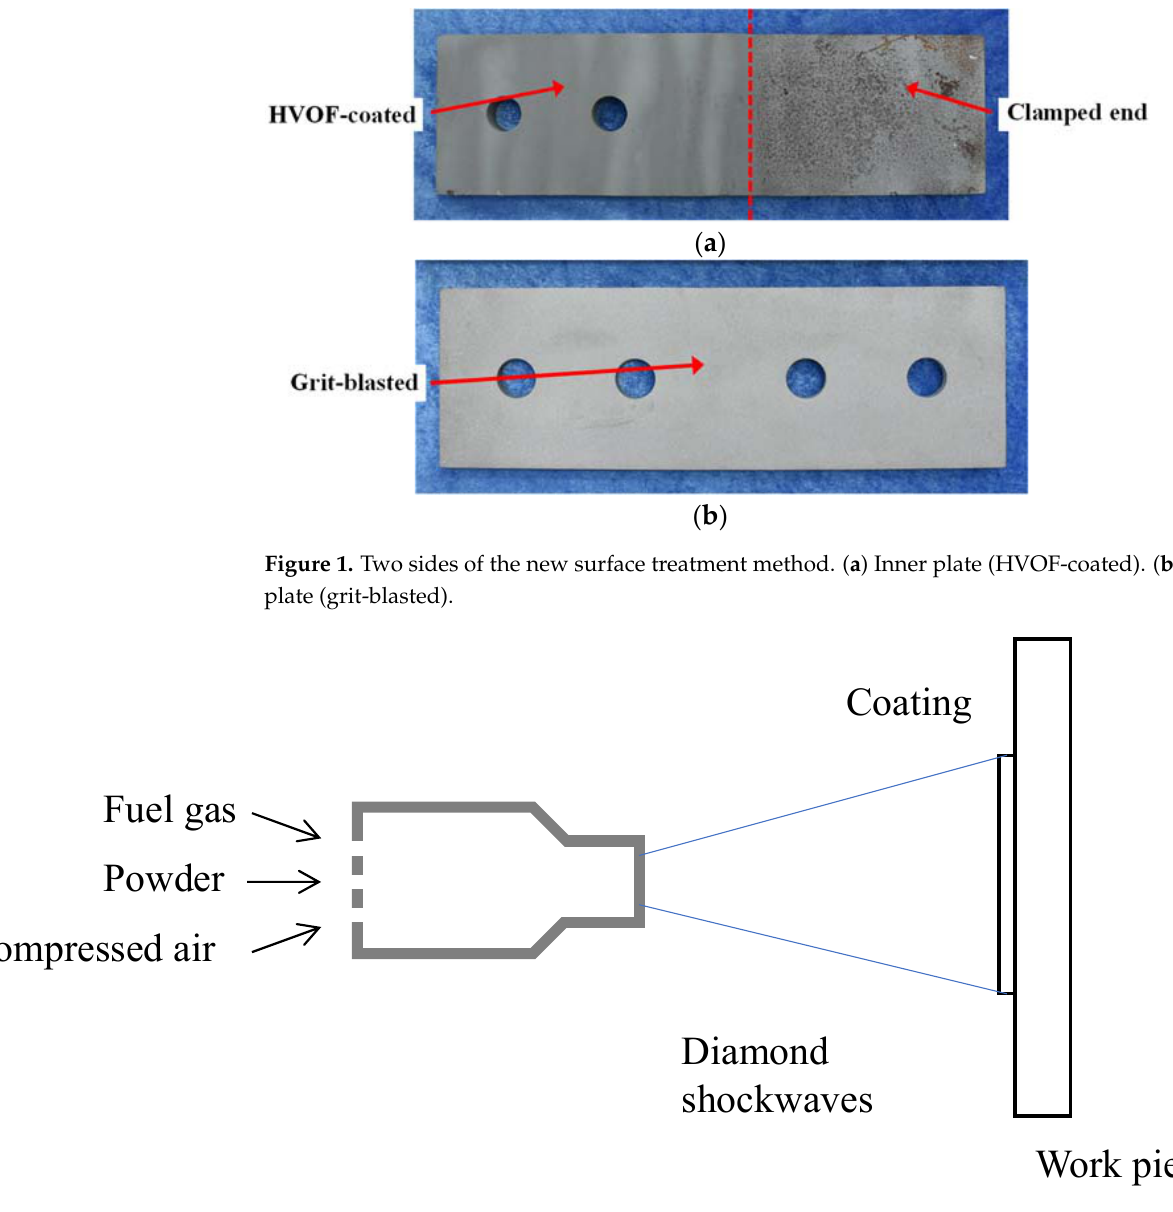
Figure 2. Schematic drawing of the HVOF thermal spraying system. gray part is the base layer of the stainless steel plate and the white part is the coating.